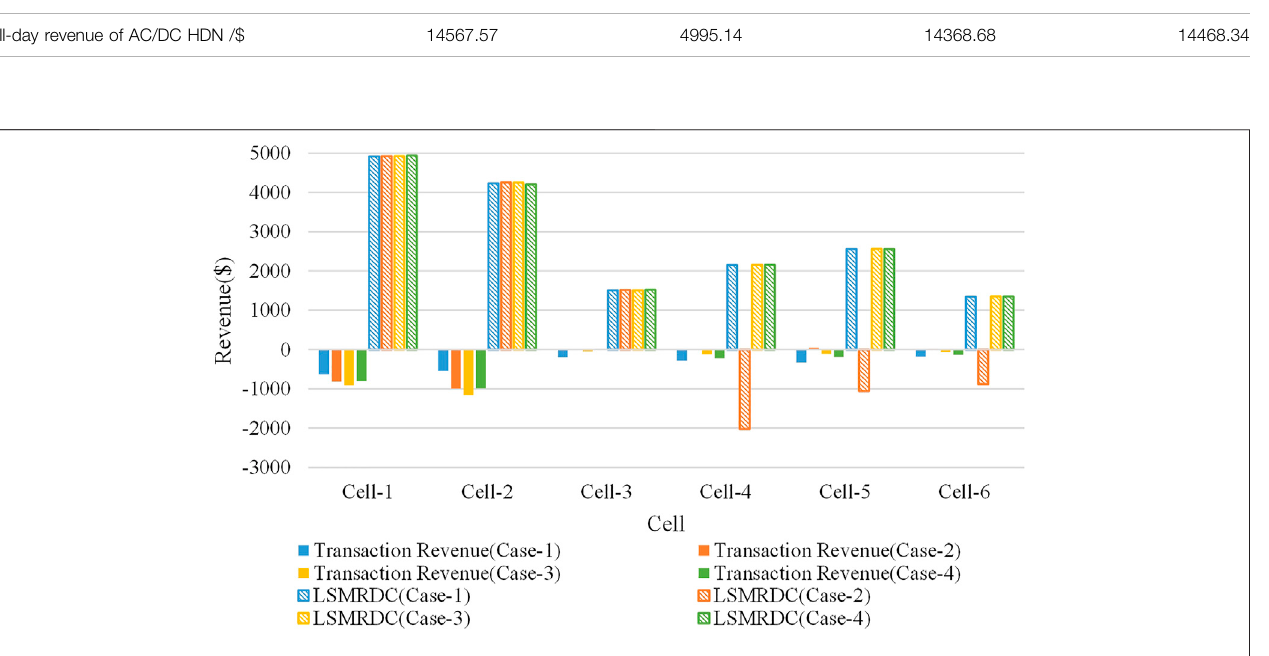
FIGURE 6 | The breakdown of all-day revenue for each